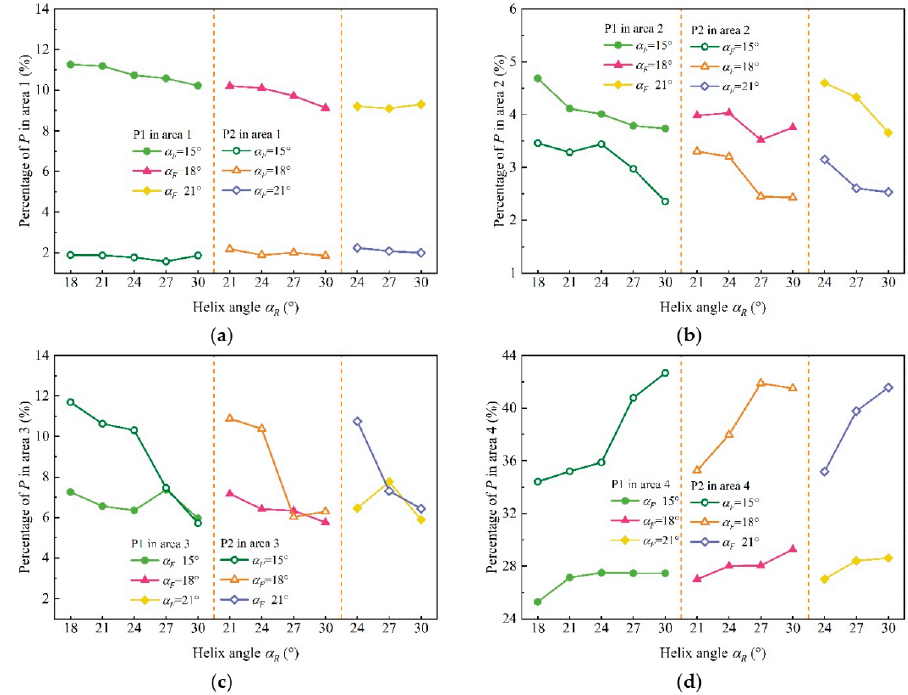
Figure 18. The distribution of particles in P1 and P2 in different areas: ( a ) area 1; ( b ) area 2; ( c ) area 3; ( d ) area